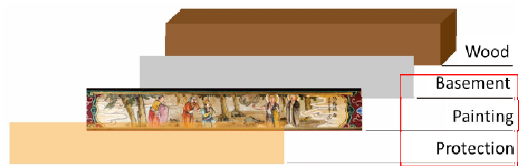
Figure 6. Test range was considered by PC, EMC chart of cedar and the monitoring tendency